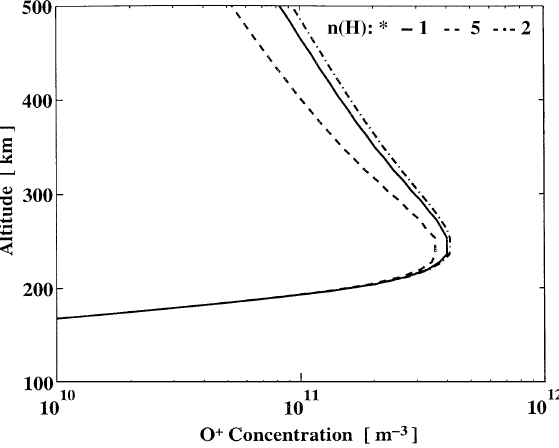
Fig. 9. Effect, in the altitude range of interest, of the atomic hydro- gen on the O (cid:96) -ion-concentrationprofile. The full line corresponds to the standard adjustment, the dashed line to atomic-hydrogen con- centration multiplied by 5 and the dot - dashed line to atomic-hydro- gen concentration divided by